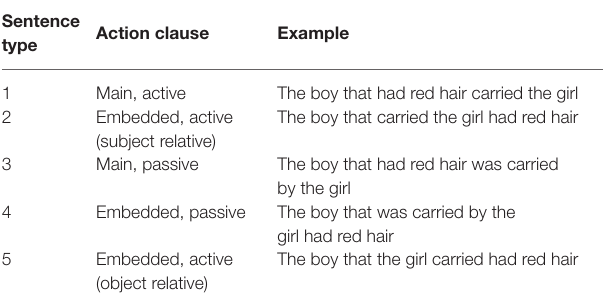
TABLE 1 | Examples of relative clause sentence types, with each type containing an action clause and a descriptive clause (adapted from Martin, 1987).